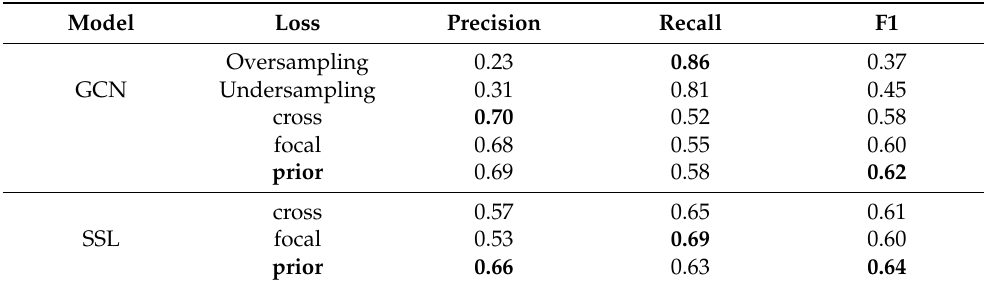
Table 1. The experimental results of performace metrics on Graph37-42 with different methods and